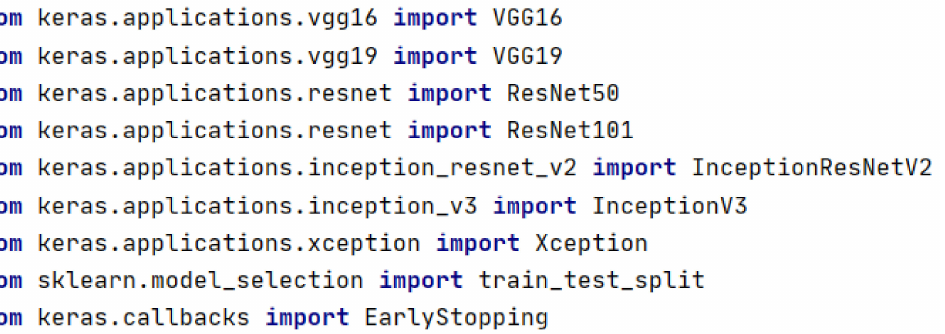
Figure 2. Implementation of our CNN models using the Keras